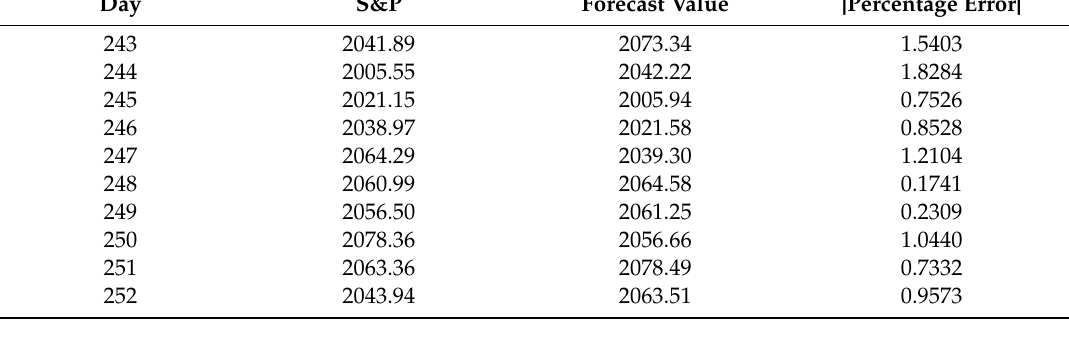
Table 4. Forecast value and error percentage of the S&P data.